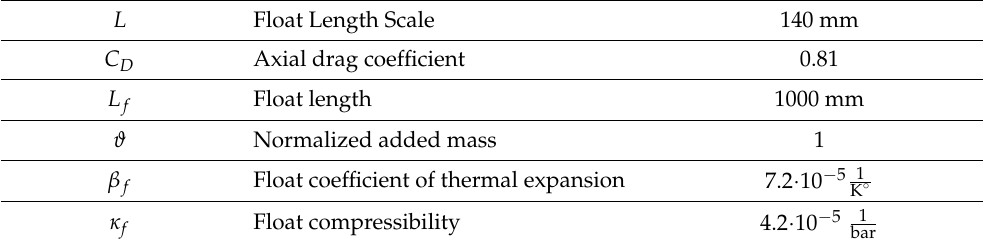
Table 3. Dynamic model